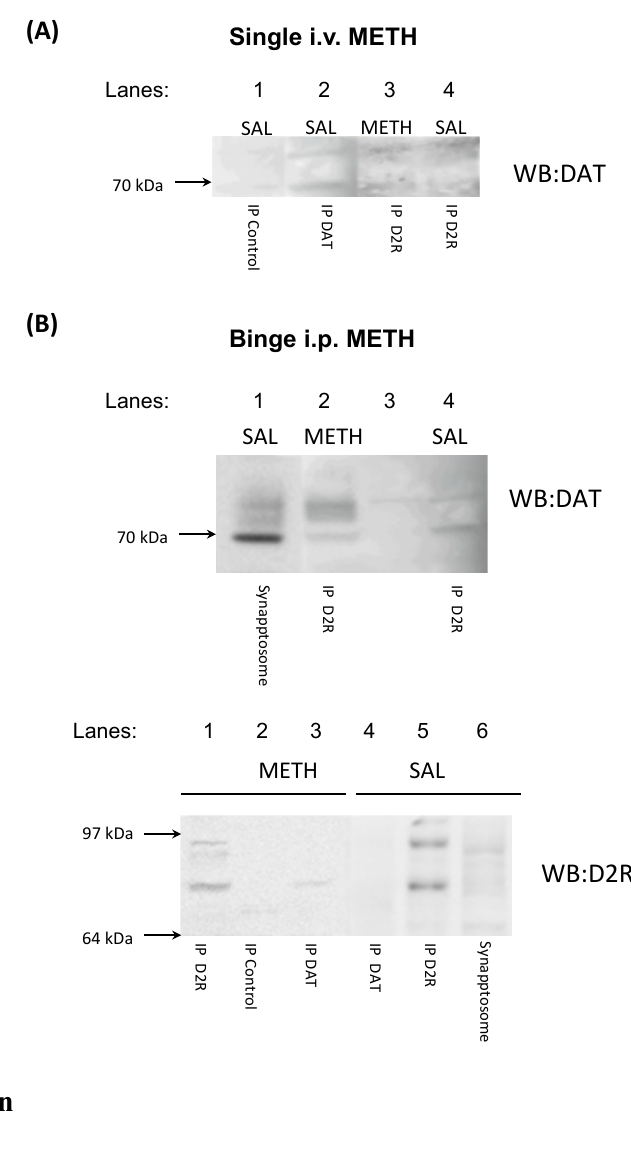
Figure 7. The assessment of dopamine pre-synaptic D2 autoreceptor-dopamine transporter (D2S-DAT) interactions after single and binge METH. Synaptosomes from saline- and METH-treated rats were subjected to co-immunoprecipitation using antibodies against DAT or D2 receptor (D2R). ( A ) Single METH (6 mg/kg, i.v.) did not cause any apparent changes to the levels of D2S-DAT complex (lane 3 vs. 4); ( B ) binge METH (4 × 10 mg/kg, every 2 h, i.p.) increased the levels of D2S-DAT complex (top: lane 2 vs. 4; bottom: lane 3 vs. 4). Controls: IP Control—negative control, Synaptosome—positive control. Abbreviations: IP, immunoprecipitation; i.p., intraperitoneal; i.v., intravenous; METH, methamphetamine; SAL, saline; WB, western